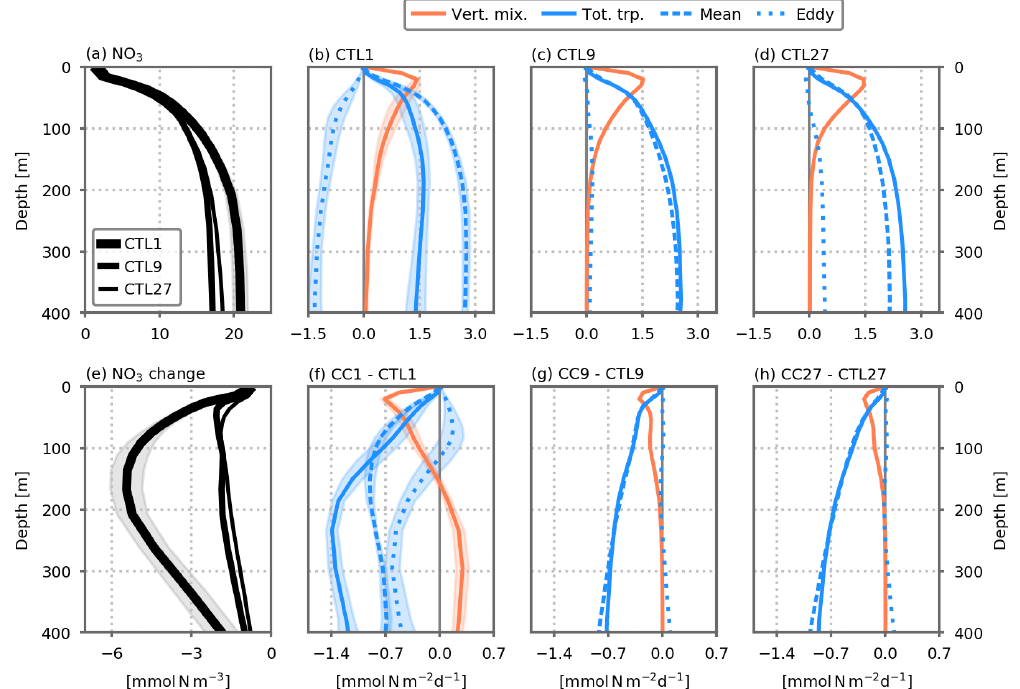
Figure 4. Nitrate concentrations (mmolNm − 3 ) and nitrate supplies (mmolNm − 2 d − 1 ) averaged over the model’s subpolar box (dashed horizontal black lines in Fig. 3). (a) Nitrate profiles in the preindustrial control simulations, for the three resolutions. (b, c, d) Dynamical nitrate supplies, cumulated between the surface and depth D in the preindustrial control simulations, against D . (e, f, g, h) Changes in these profiles between the climate change and preindustrial control simulations. In the coarse-resolution simulations (CTL1/CC1), the profiles show the average of the five 1 ◦ configurations. Shading indicates ± 1 standard deviation. The total transport term (solid blue line) comprises the sum of vertical advection across depth D and meridional advection through the southern border of the model’s subpolar box; in the case of the 1 ◦ simulations, total transport also includes eddy parameterizations (including advection by bolus velocity and isopycnal mixing). Total transport is the sum of mean and eddy transport. In the fine-resolution simulations (CTL9/CC9, CTL27/CC27), the mean and eddy transport terms are derived from Reynolds decomposition (see the Methodology section). In the coarse-resolution simulations (CTL1/CC1), the mean transport represents the resolved transport by the coarse-resolution velocity field, and the eddy transport includes the two eddy parameterization terms. See also Figs. A5 and A6 for individual fluxes. All profiles are averaged over years 66 to